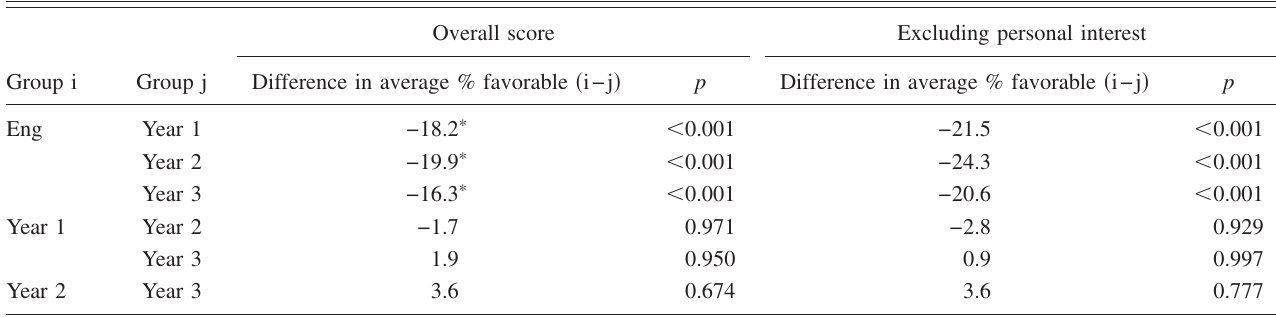
TABLE II. Detailed Games-Howell test results for overall survey score and overall score excluding personal interest category. Difference in average percent (cid:1) % (cid:2) favorable, with posthoc test results (cid:4) the asterisk (cid:1) * (cid:2) indicates statistical significance at the 0.05 level (cid:5)